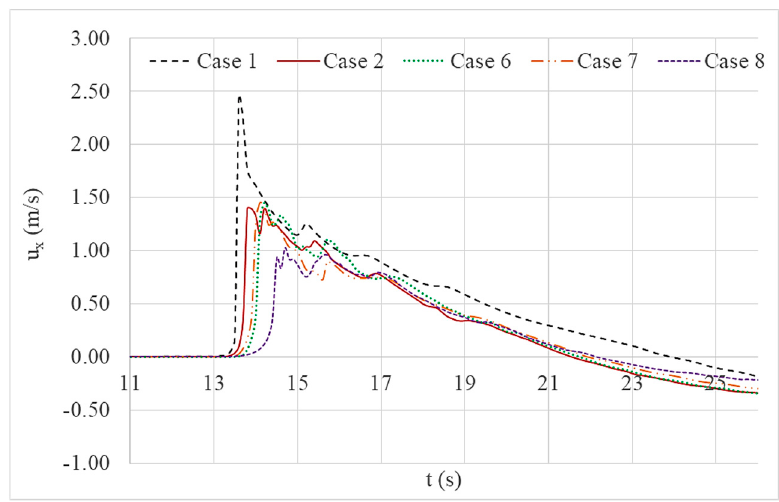
Figure 12. Comparison of current velocity (x-component) variations at location D.